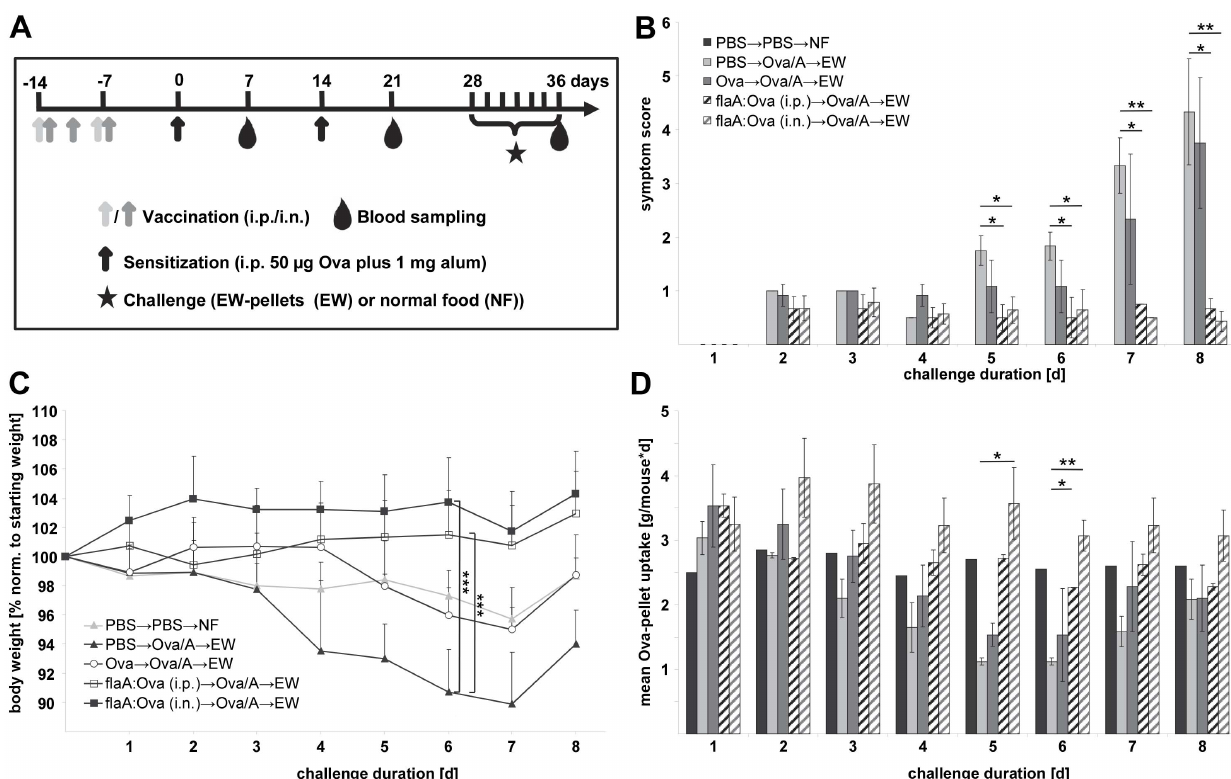
Figure 1. Intranasal and intraperitoneal vaccination with rflaA:Ova prevent Ova-induced intestinal allergy. Control (PBS R PBS R NF), Ova-sensitized but unvaccinated animals (PBS R Ova/A R EW), Ova-vaccinated (Ova R Ova/A R EW) and rflaA:Ova-vaccinated (flaA:Ova R Ova/A R EW) animals were continuously challenged with Ova-containing pellets (EW) for 8 days ( A ). Mean symptom scores ( B ), body weight normalized to the individual body weight before challenge ( C ), and mean EW-pellet uptake per mouse and day ( D ), were analyzed (n=6 mice per group). NF: normal food.